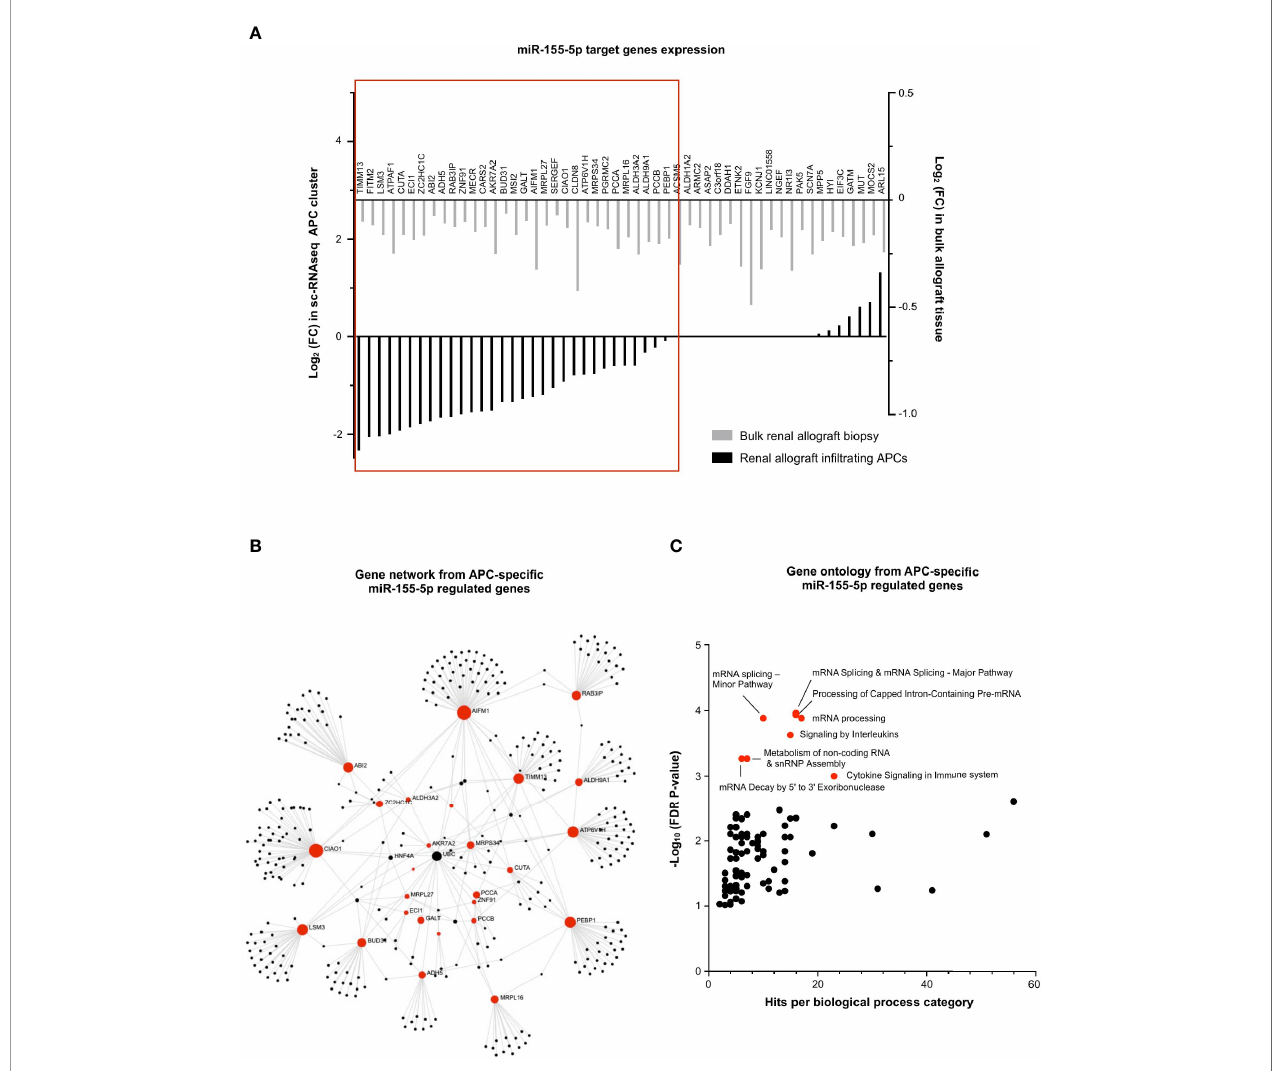
FIGURE 8 | miR-155-5p regulates mRNA splicing in APCs during MVI. (A) Bar plots showing the differential expression of each individual miR-155-5p-target genes between MVI + and MVI- samples, in the bulk transcriptomic analysis (light gray) or in the APCs cluster from sc-RNAseq analysis (black). Red frame indicates 31 genes, concordantly downregulated in MVI in bulk tissue and in the APCs cluster. (B) Gene network corresponding to the 31 downregulated genes in MVI built on Omicsnet. (C) Gene ontology and pathway enrichment analysis based on Omicsnet and Reactome databases. The name of the top 10 enriched pathways in term of adjusted P-value are shown (red